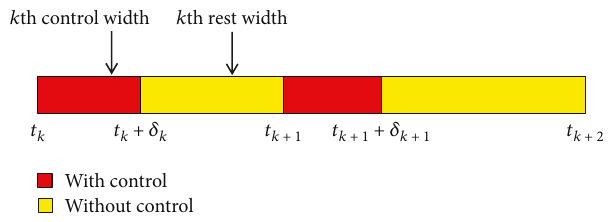
Figure 1: Sketch map of aperiodically intermittent control